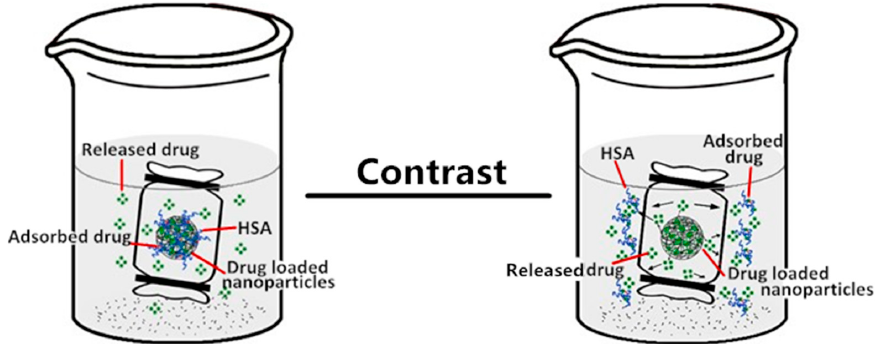
Figure 12. Drug released from nanoparticles upon HSA complexation and in the HSA release